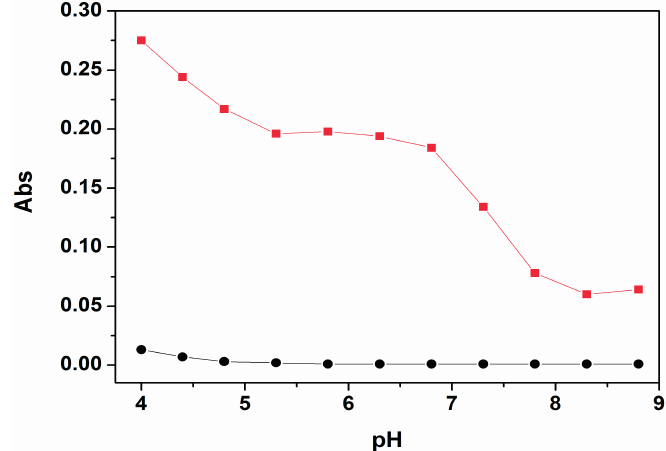
Figure 1. pH-dependence of P (10 µM) (  ) and P (10 µM) plus Cu 2+ (100 µM) ( ■ ) in HEPES buffers as a function of different pH values in ethanol-water solution (9:1, v:v, 20 mM HEPES). The pH was modulated by adding 1.0 M HCl or 1.0 M NaOH in HEPES